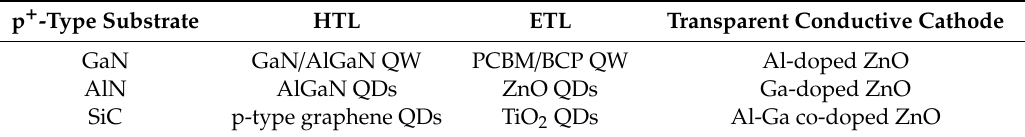
Table 3. Potential candidates as the p + -type substrate, hole transport layer (HTL), electron transport layer (ETL) and transparent conductive